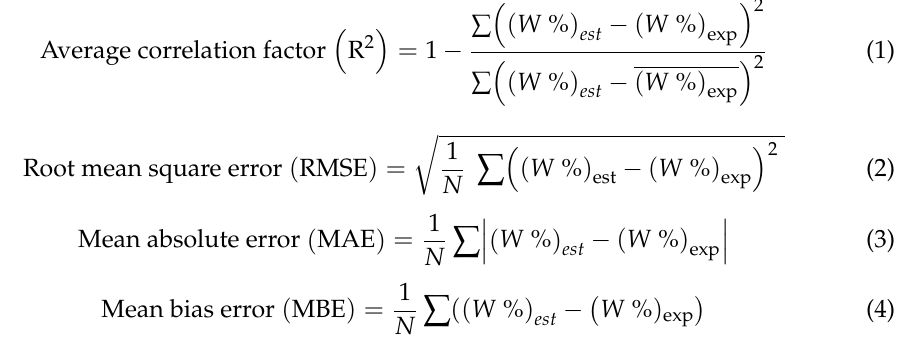
Figure 2. DTG curves of PP at different heating rates.